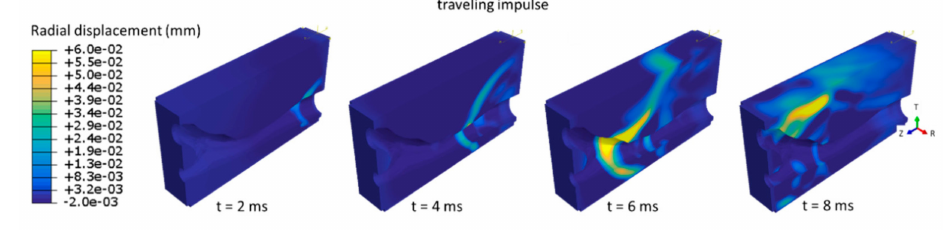
Figure 8. Radial displacement depicting wave propagation at four time instances for the traveling impulse with a velocity of 7 m / s. Note that a cylindrical coordinate system is used in this figure to obtain a more intuitive visual representation of wave